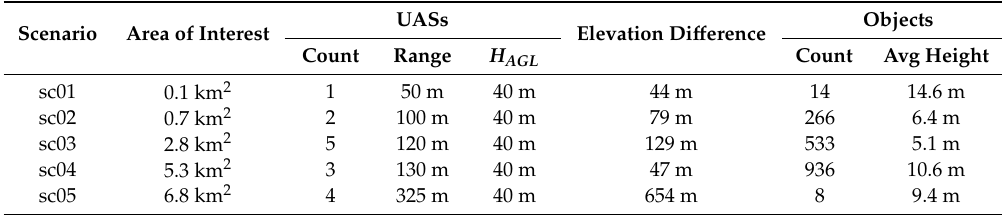
Table 1. Scenarios for experiments.